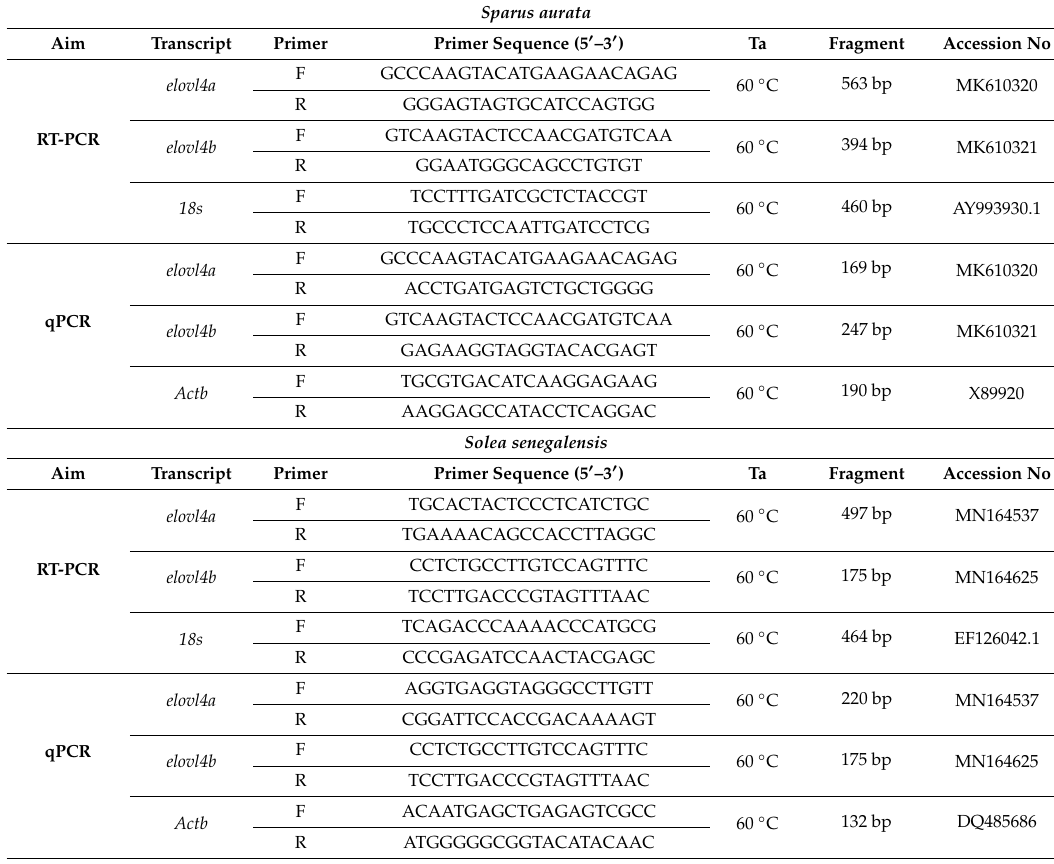
Table 6. Primers used for reverse transcriptase PCR (RT-PCR) and real-time quantitative PCR (qPCR) of Sparus aurata and Solea senegalensis